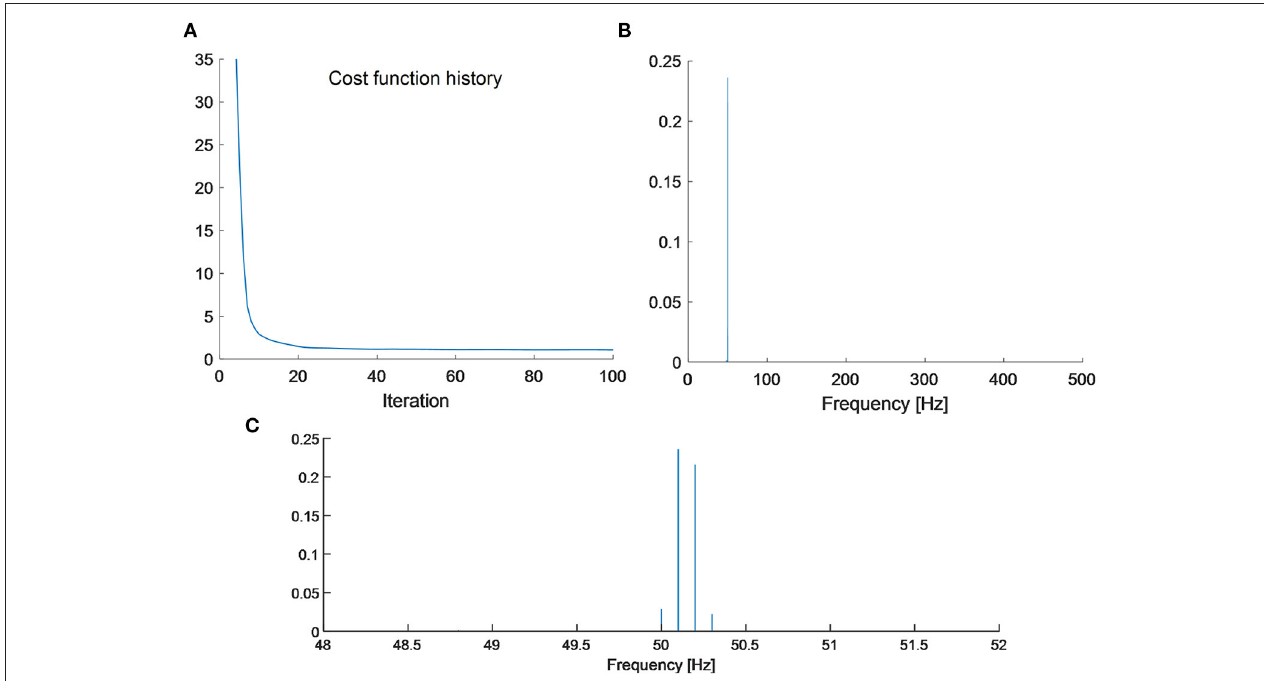
FIGURE 3 | (A) The cost function history; (B) sparse Fourier spectrum by the proposed ASD methodology; and (C) zoom-in plot of sparse Fourier spectrum.